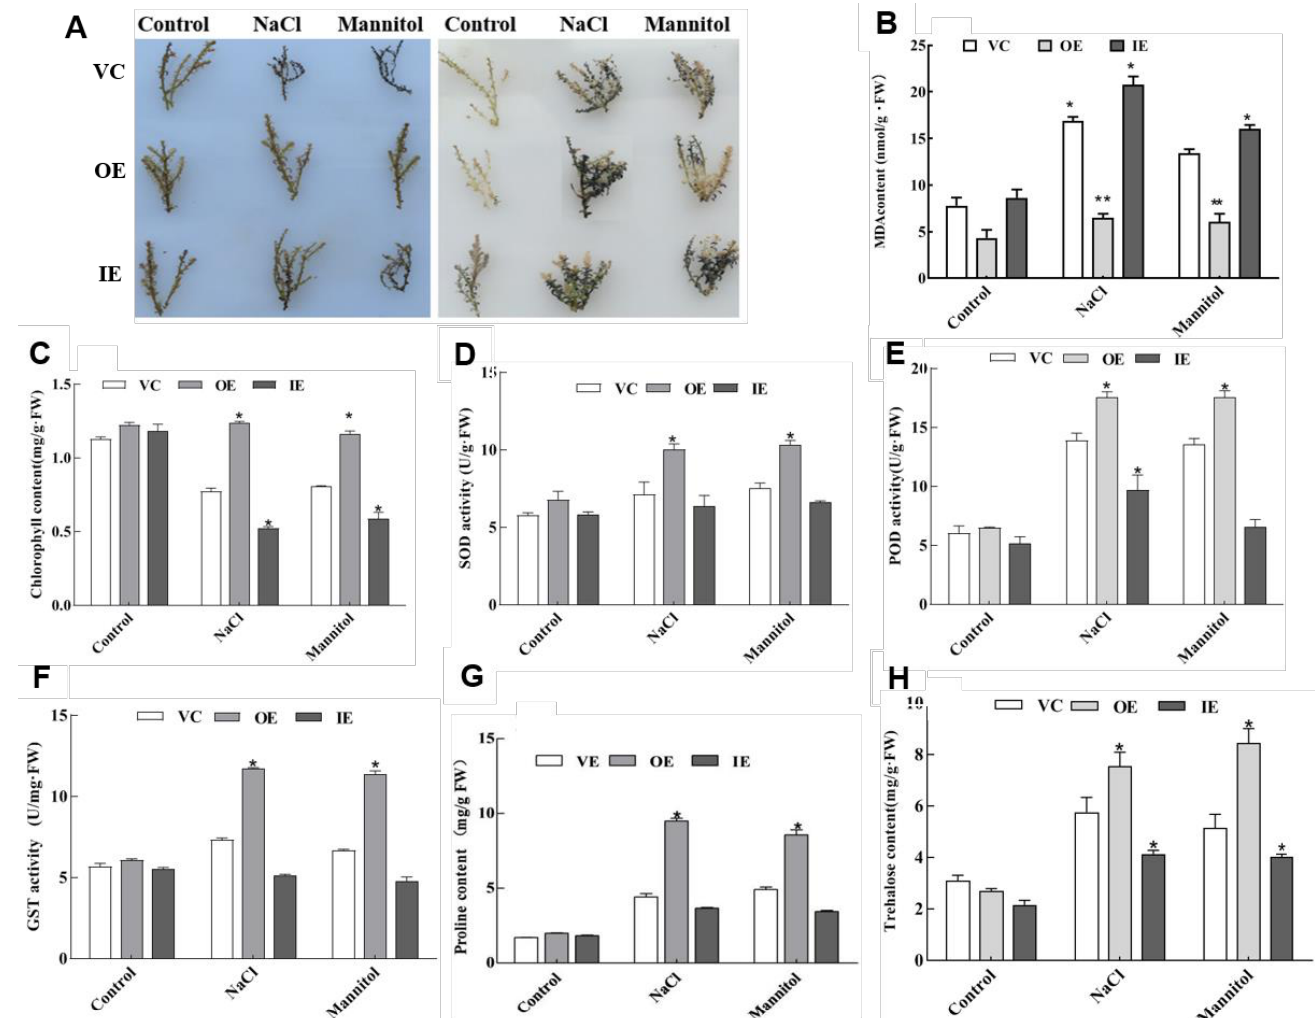
Figure 6. Histochemical staining and physiological analyses in transgenic T. hispida plants. ( A ) Detection of ROS levels in transgenic T. hispida plants. Histochemical staining by DAB and NBT revealed the accumulation of H 2 O 2 and O 2 − , respectively. (B–H) Physiological analysis of transgenic T. hispida plants, including MDA contents ( B ), chlorophyll contents ( C ), SOD activity ( D ), POD activity ( E ), GST activity ( F ), proline contents ( G ) and trehalose contents ( H ). The plants were grown in 1/2 MS medium or 1/2 MS medium containing 150 mM NaCl or 200 mM mannitol for 24 h and used for analysis. VC: the pROKII vector control transformed T. hispida plants; OE: overexpression of ThNAC4 in T. hispida plants; and IE: ThNAC4 RNAi-silenced T. hispida plants. The error bars represent the standard deviations of the mean measurements, which were calculated from three independent experiments. *, ** indicates a significant difference (* p < 0.05, ** p < 0.01) compared to the control